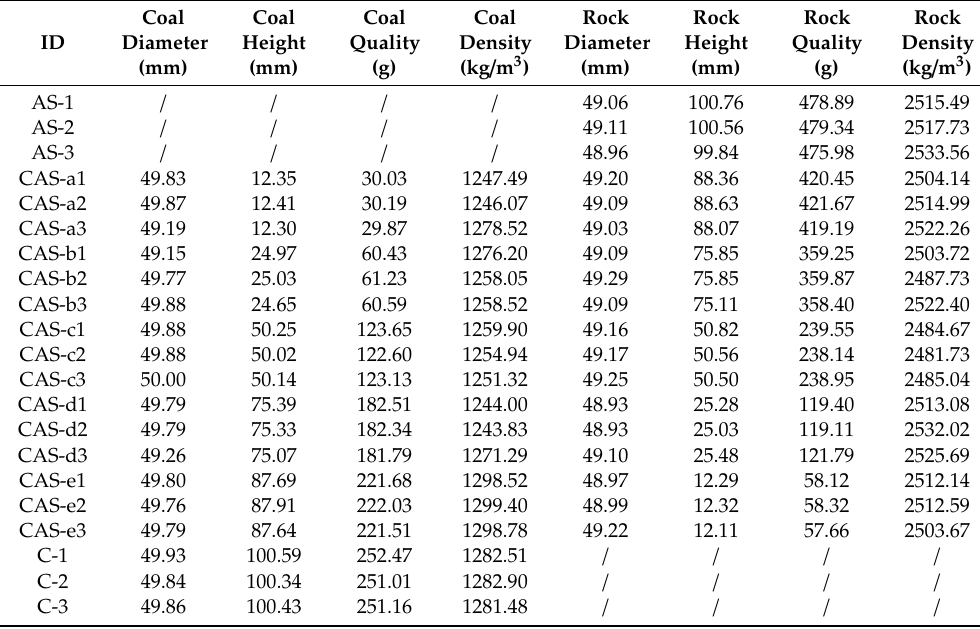
Table 2. Critical parameters of prepared specimens.